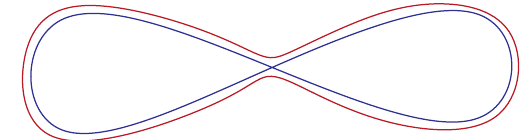
Figure 6: Figure for example in Section 3.6; the curve c is blue and the curve 􏽥 c is